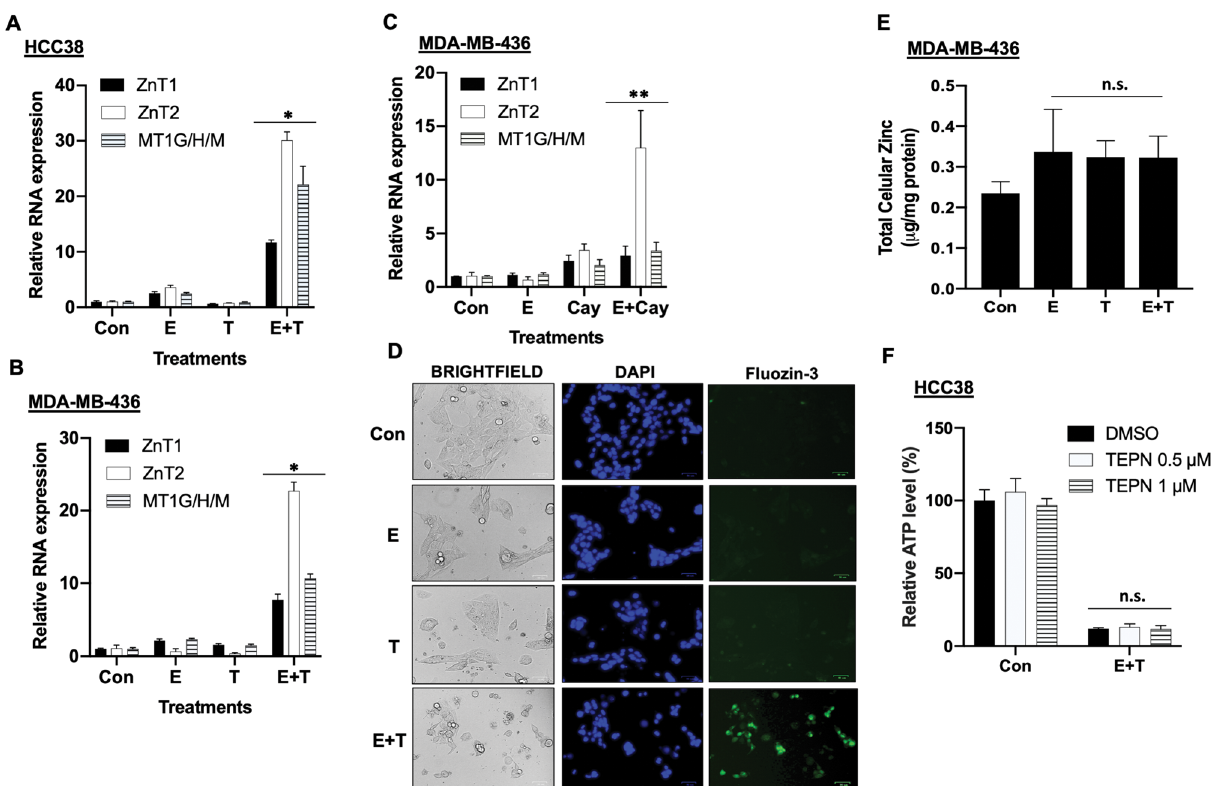
Figure 5. The zinc-related gene response is triggered by erastin plus tubacin. (A,B) RT-qPCR analysis of zinc-related gene expression (n = 3; *p < 0.005) in HCC38 cells ( A ; 24 h) and MDA-MB-436 ( B ; 36 h) under treatments of either control (Con), 5 μM erastin (E), 5 μM tubacin (T), or erastin plus tubacin (E + T). (C) RT-qPCR analysis of zinc-related gene expression (n = 3; **p < 0.005) in MDA-MB-436 (36 h) under treatments of either control (Con), 5 μM erastin (E), 5 μM Cay10603 (Cay), or erastin plus Cay10603 (E + Cay). (D) Live cell imaging of HCC38 cells that were treated as ( A ) for 18 h and stained by Fluozin-3 and DAPI (Hoechst 33342). The size of the scale bar is 100 μm. (E) Total cellular zinc was measured by ICP-AES analysis (n = 3; n.s., not significant) in MDA-MB-436 cells under either control (Con), 5 μM erastin (E), 5 μM tubacin (T), or erastin plus tubacin (E + T) treatments for 24 h. (F) Relative cell viability of HCC38 cells under either control or E + T with different concentrations of TPEN for 48 h (n = 3; n.s., not